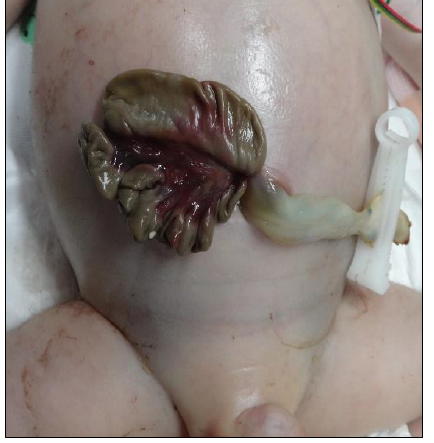
Figure 2: Closing